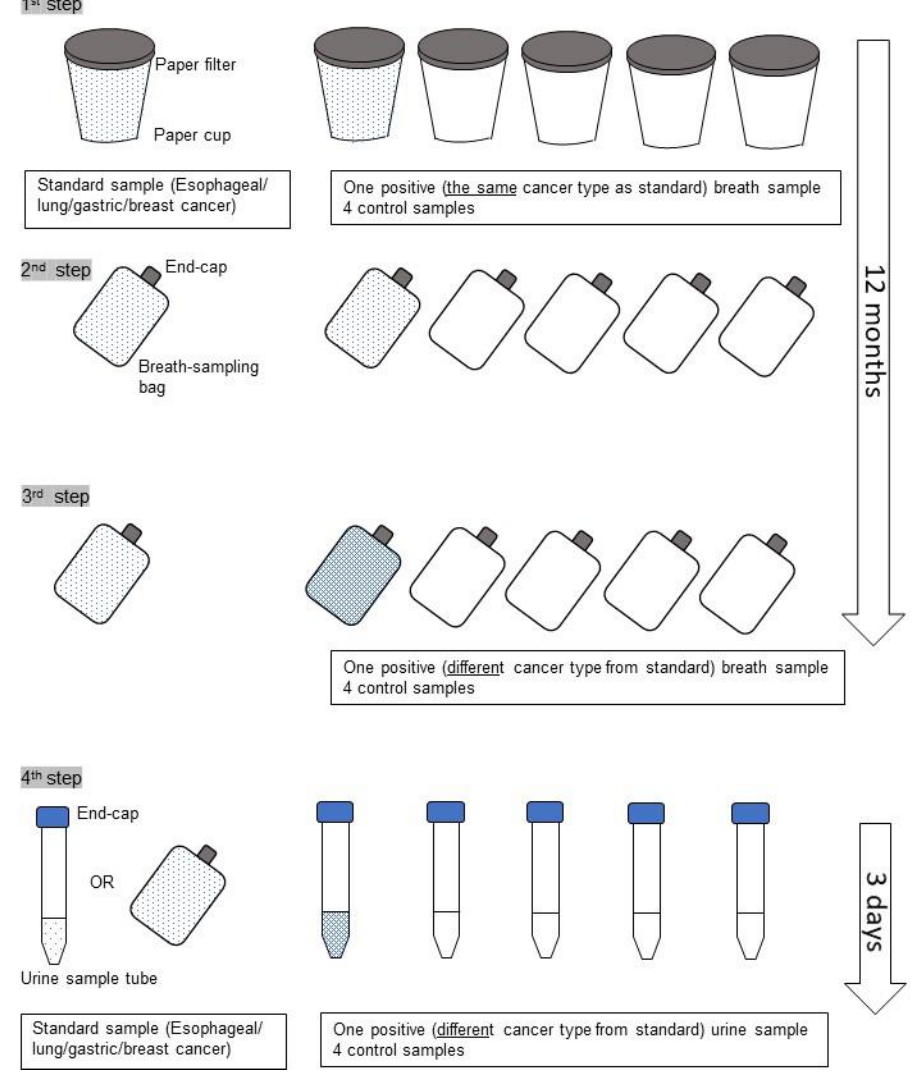
Figure 1. The four steps of the training are shown. In the first and the second step, the dog tried to detect the breath sample, which is the same cancer type as the standard. In the third step, the positive breath sample was a different cancer type from the standard. In the fourth step, urine samples were